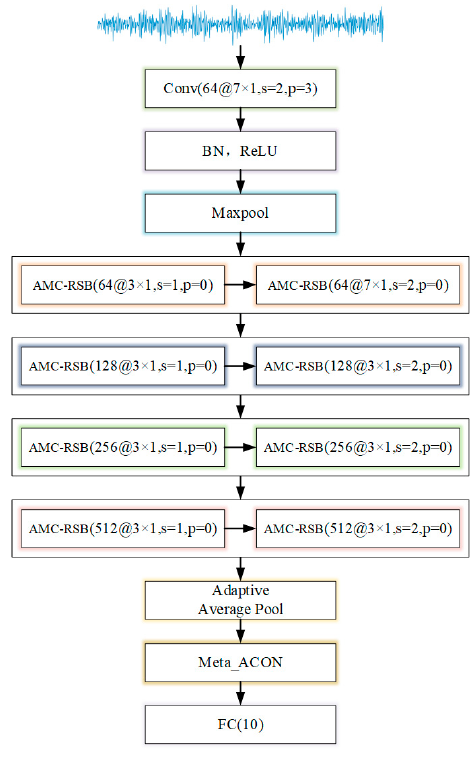
Figure 2. Overall architecture and specific parameters.